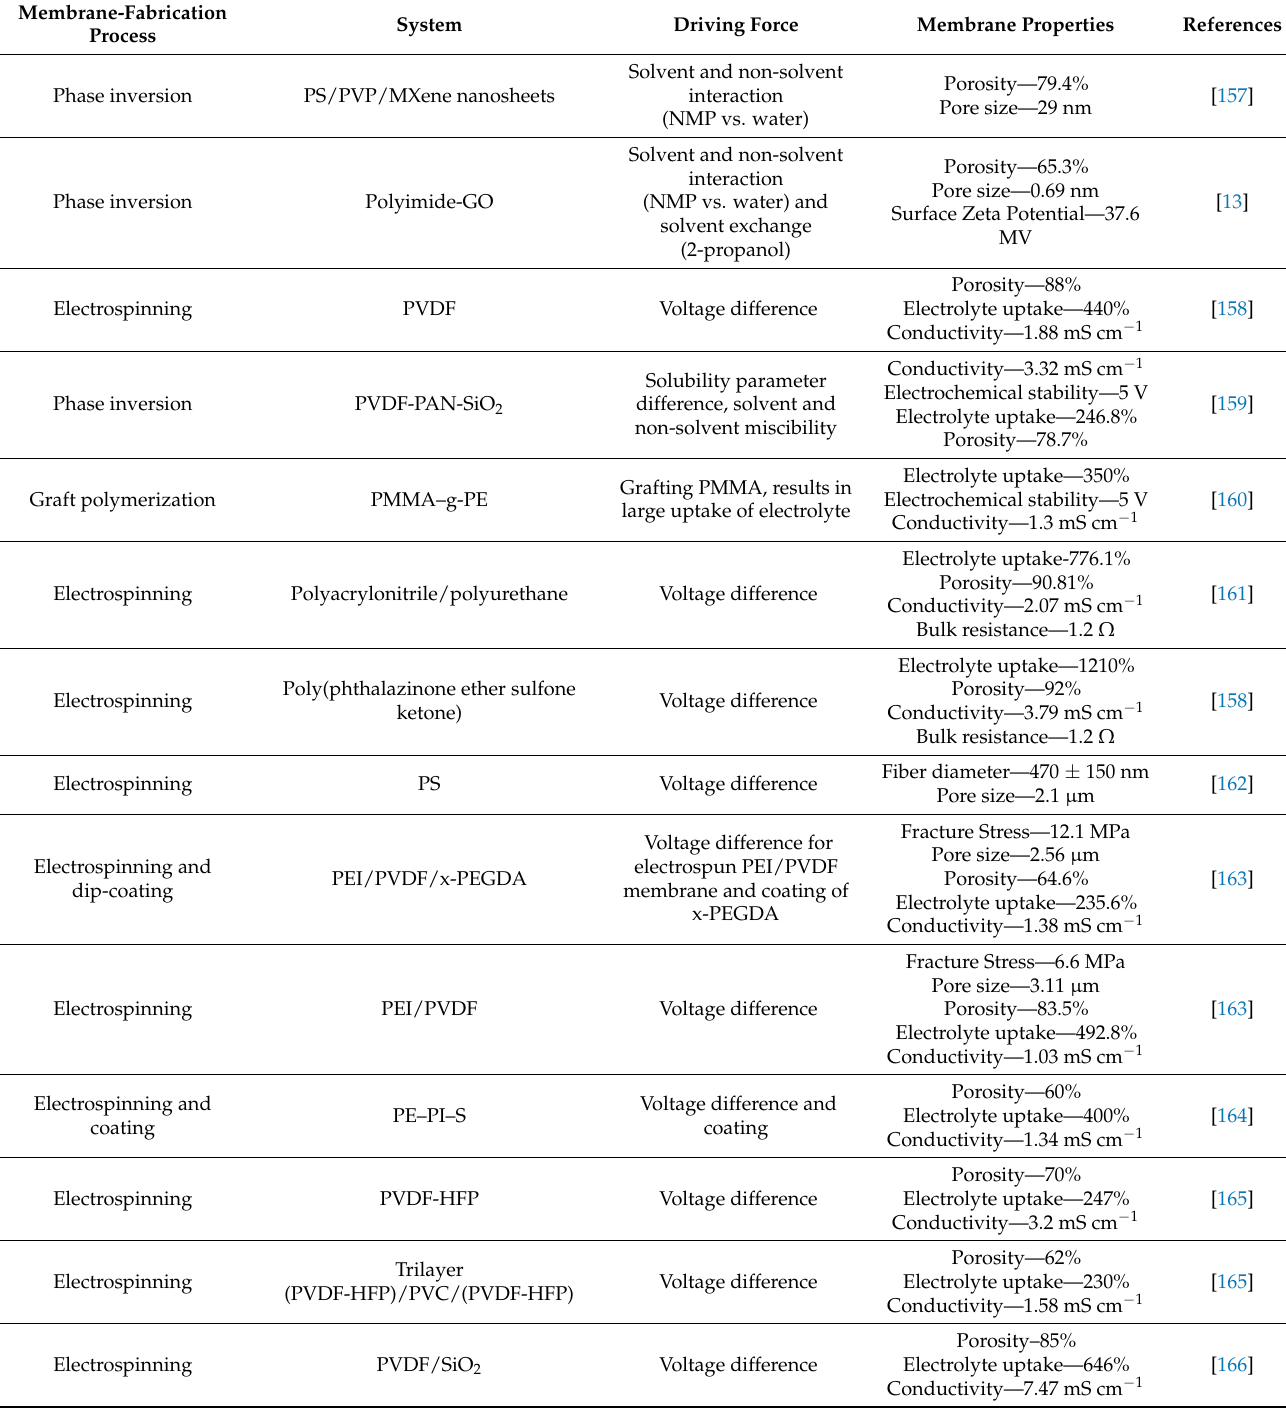
Table 2. Basic properties of some membranes with their fabrication